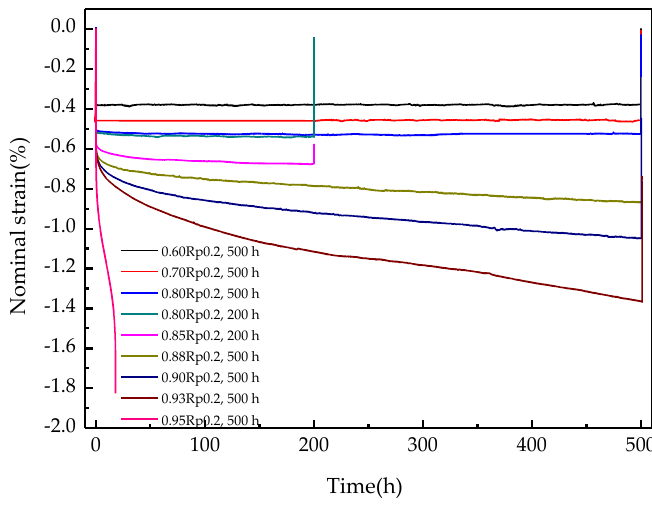
Figure 4. Strain – time curves of TA31 titanium alloy. Figure 4. Strain–time curves of TA31 titanium